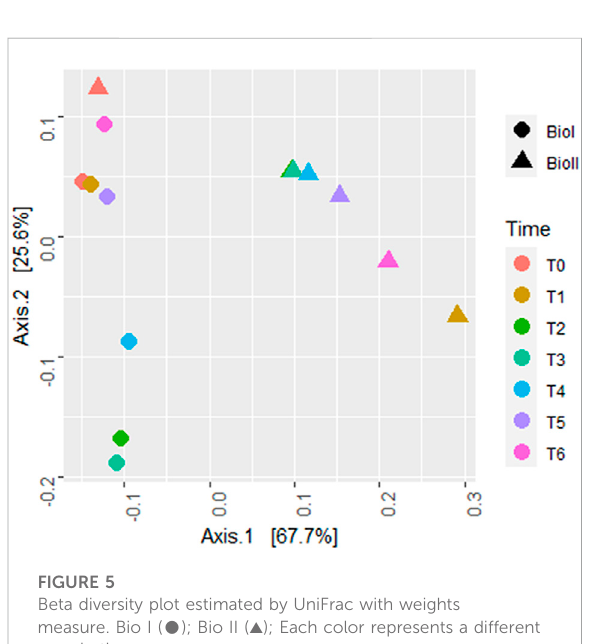
FIGURE 5 Beta diversity plot estimated by UniFrac with weights measure. Bio I ( C ); Bio II ( ▲ ); Each color represents a different sample